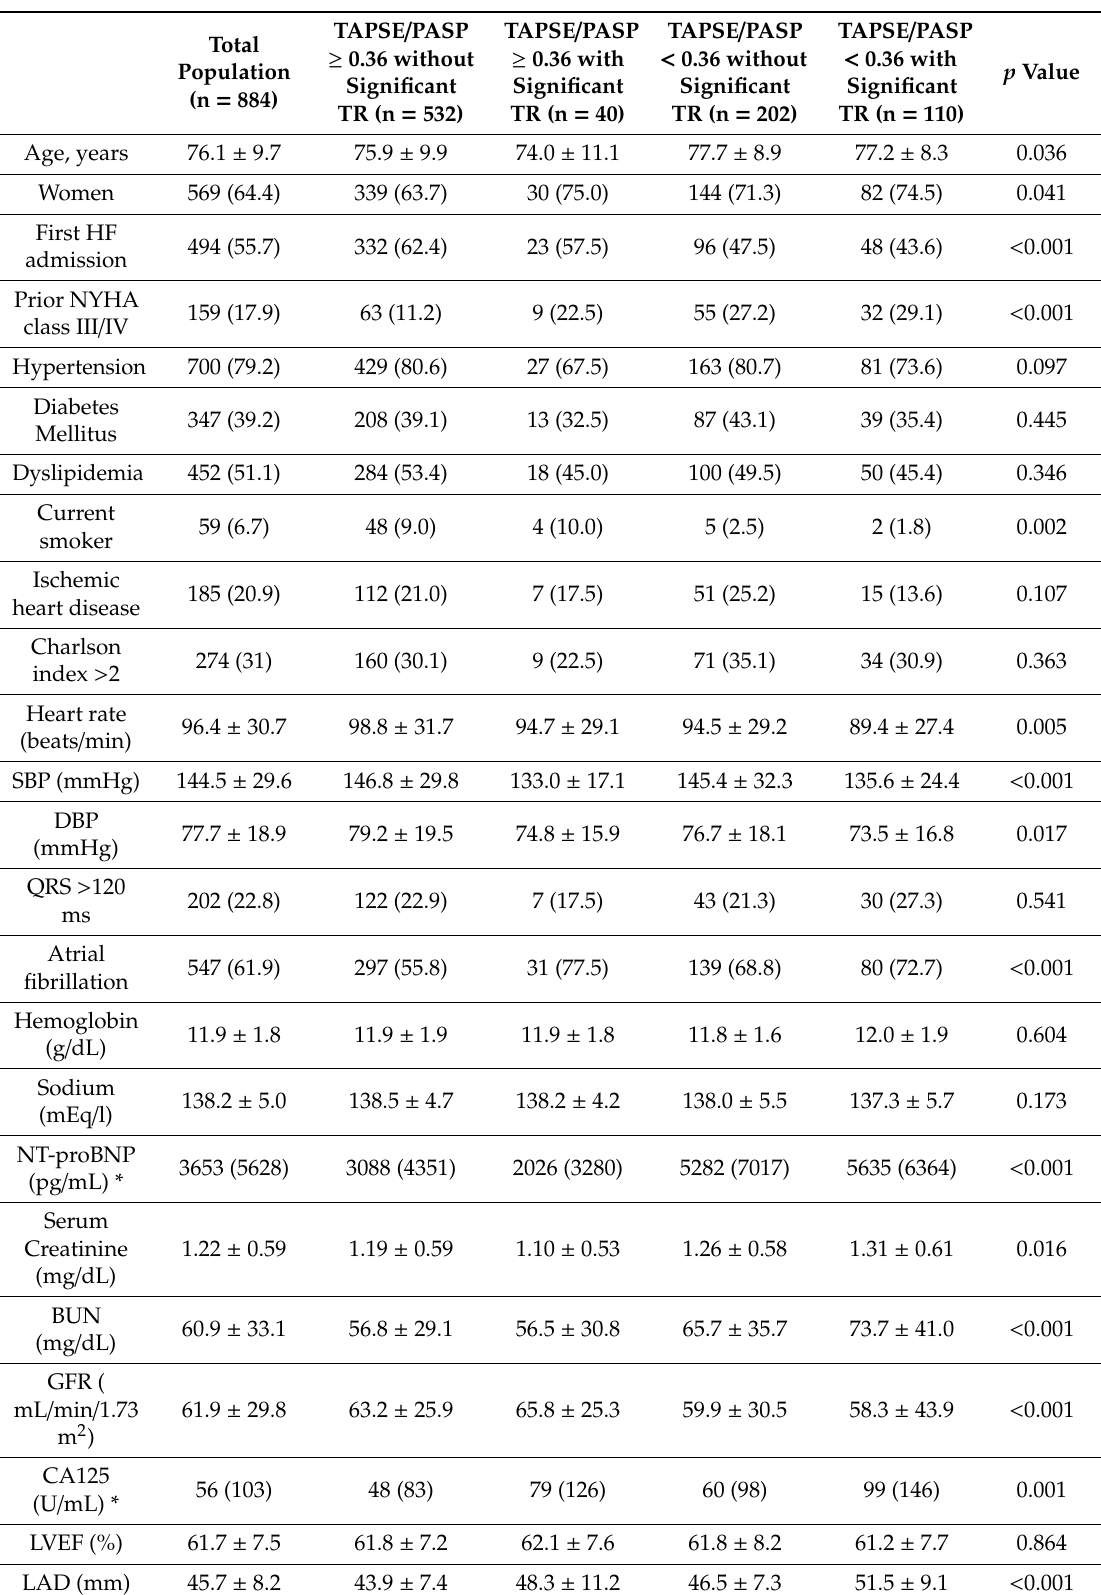
Table 1. Patient characteristics across right ventricular dysfunction